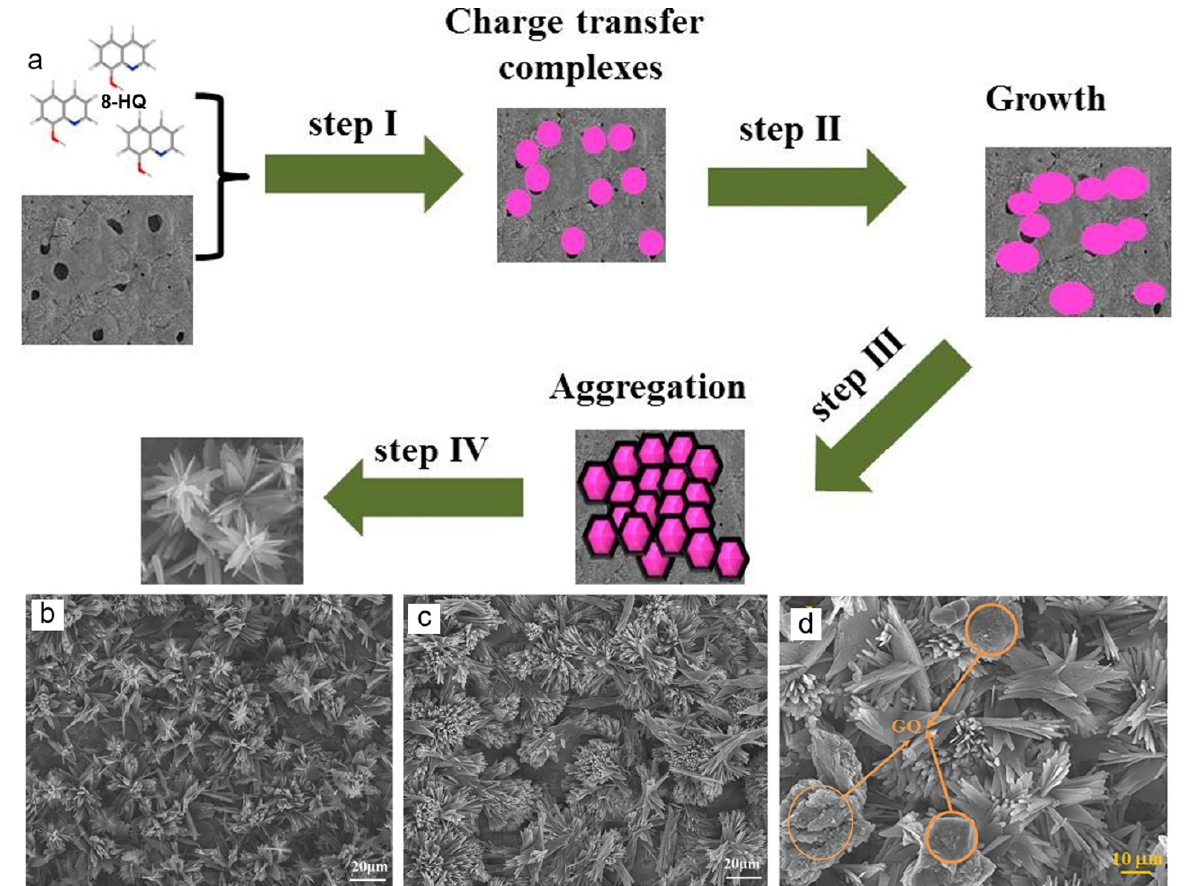
Figure 3. Schematic illustration ( a ) describing the synthetic mechanism of 8-HQ molecules self-assembled on IL-coated AZ31 Mg alloy for 1 days with different concentration of 0.05M ( b ), 0.1 M ( c ). Reproduced with permission [11]. Copyright © 2019 Elsevier. 1 M ( d ) with the additional GO layer. Reused with permission from [12]. Copyright © 2019 Elsevier .